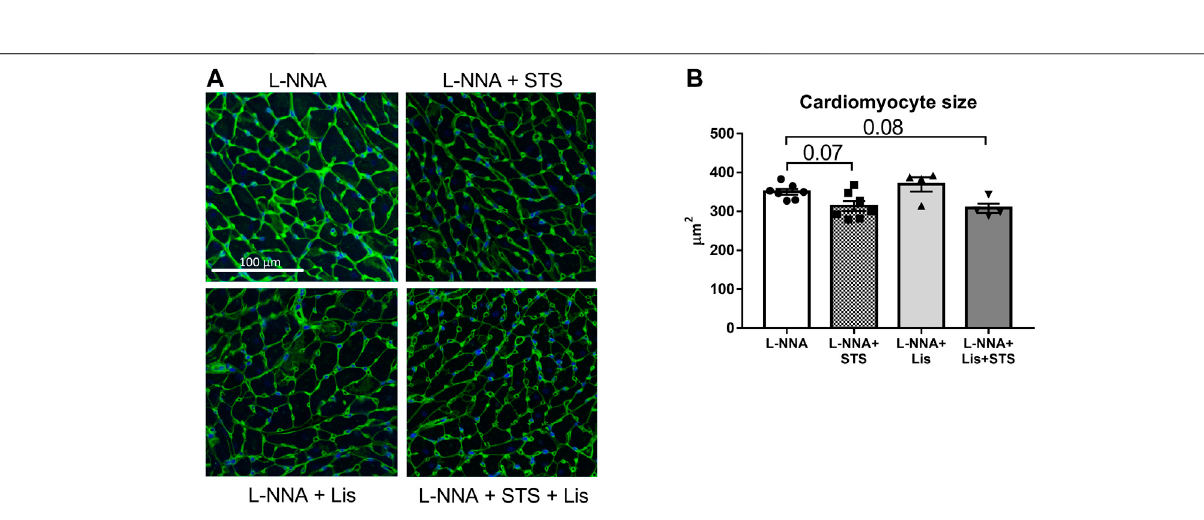
Frontiers in Pharmacology |